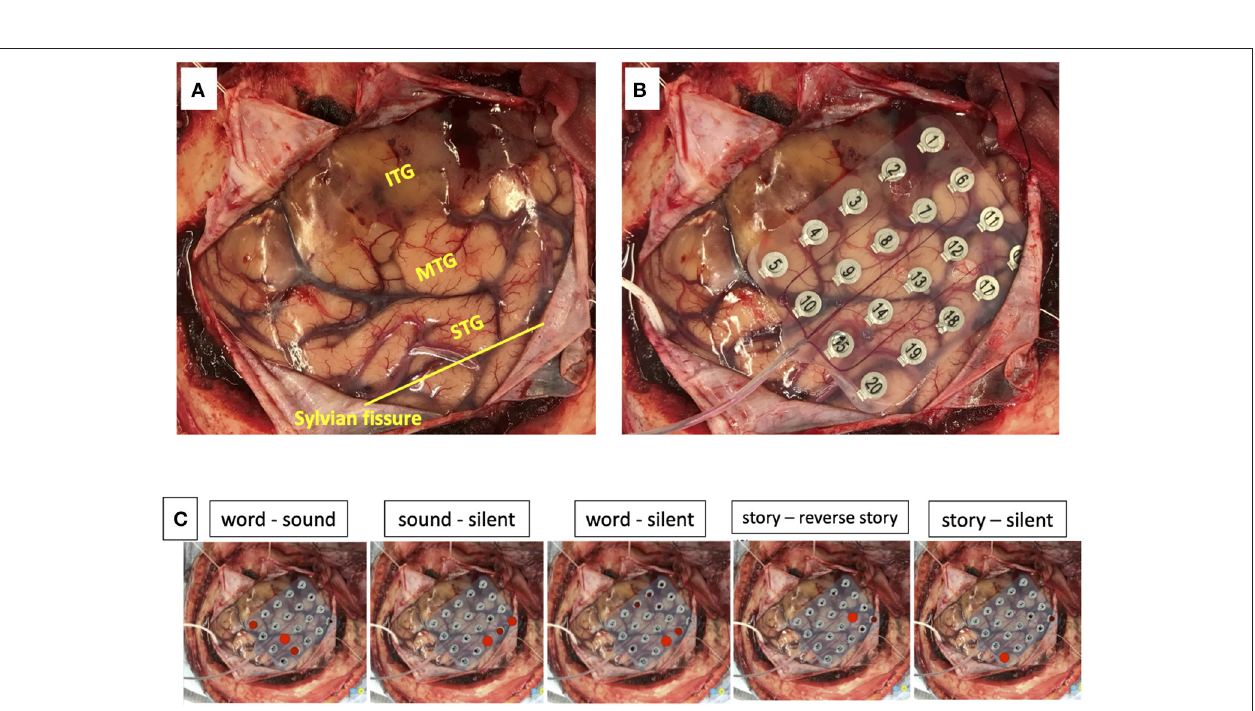
FIGURE 2 | The exposed brain surface (A) and a 20-channel ECoG grid placement (B) before resection. Red bubble meaning significant listening task-evoked high gamma activities in each task during passive language mapping (C) . STG, superior temporal gyrus; MTG, middle temporal gyrus; ITG, inferior temporal gyrus.